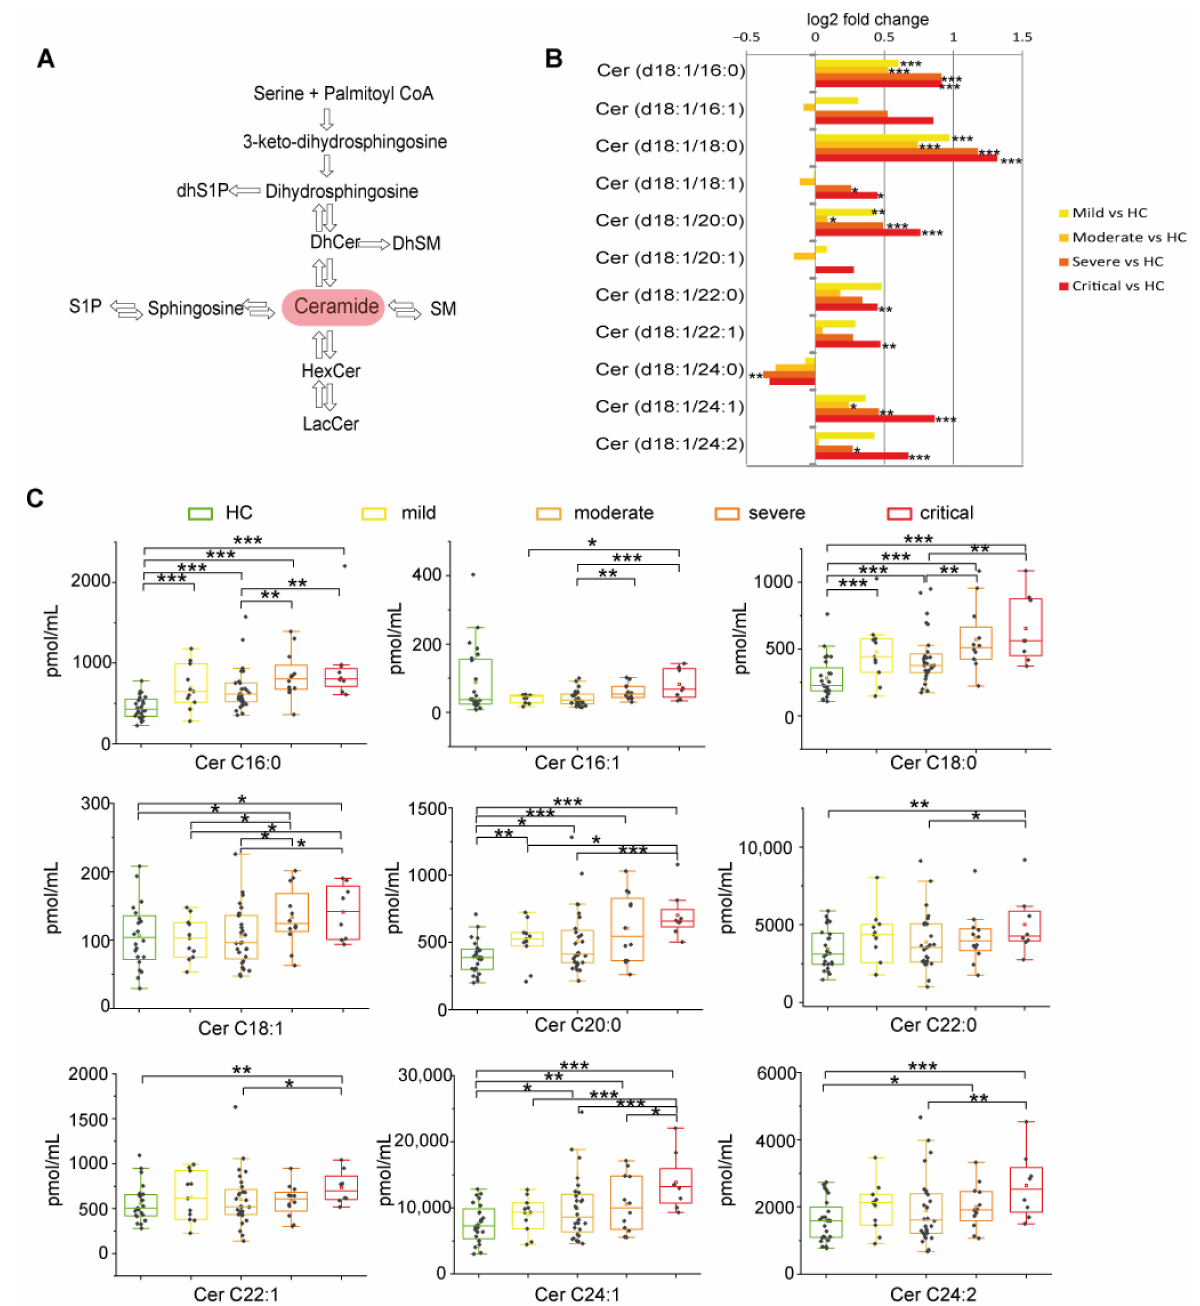
Figure 3. Ceramides changes in COVID-19. ( A ) Close up showing the central role of ceramide in the sphingolipid biosynthetic/catabolic pathway. ( B ) Log 2 fold changes in the median values of ceramides (C16:0, C16:1, C18:0, C18:1, C20:0, C20:1, C22:0, C22:1, C24:0, C24:1, C24:2) in COVID-19 severity groups vs. healthy controls (HC). ( C ) Box plots of serum ceramide species changed according to COVID-19 severity (C16:0, C16:1, C18:0, C18:1, C20:0, C22:0, C22:1, C24:1, C24:2). Each measurement was performed in triplicate. Data were analyzed using Kruskal-Wallis ANOVA, followed by Dunn’s post hoc test for multiple comparisons. * p -value < 0.05, ** p -value < 0.01, *** p -value <